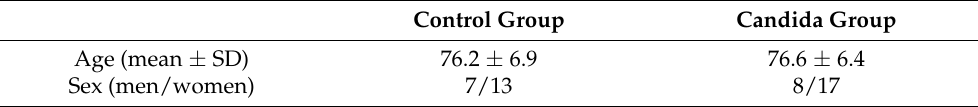
Table 1. Patient characteristics.